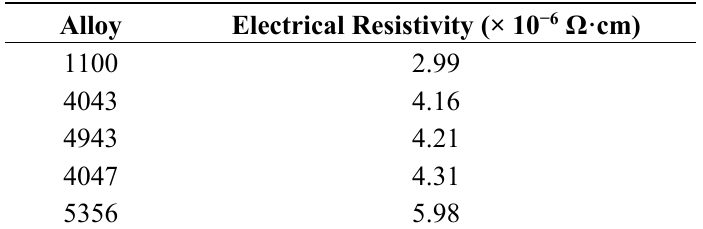
Table 3. Electrical Resistivity of Common Aluminum Weld